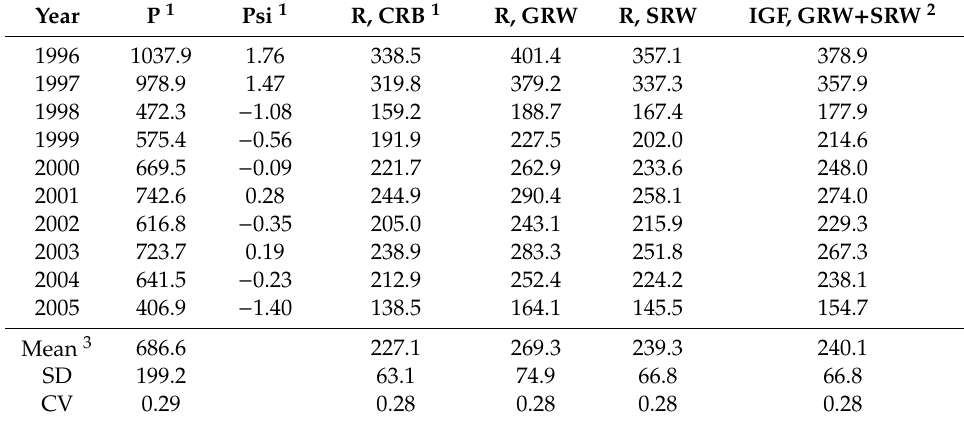
Table 4. For the control period (1996–2005), surface-weighted yearly series of (i) P and R in the CRB and in upstream GRW and SRW areas, and (ii) IGF from the GRW and SRW area contributing to CRB.